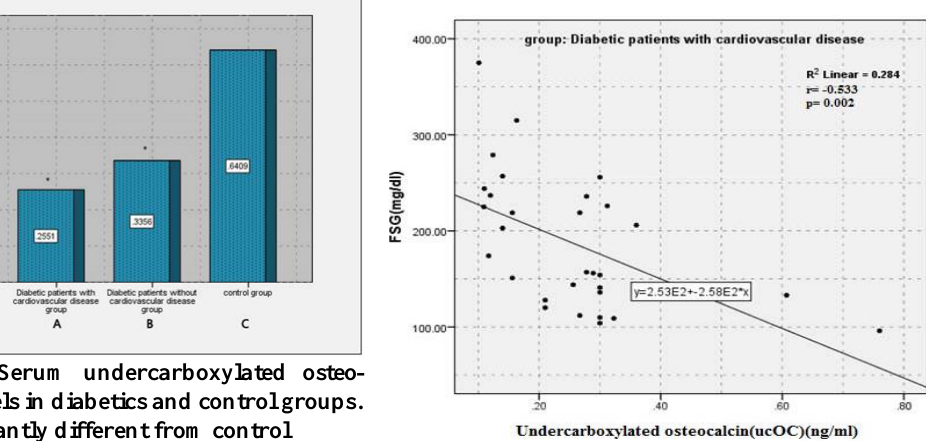
Figure 2. Correlation between undercar- boxylated osteocalcin (ucOC) (ng/ml) and fasting serum glucose (FSG) (mg/dl) in diabetic patients with cardiovascular disease